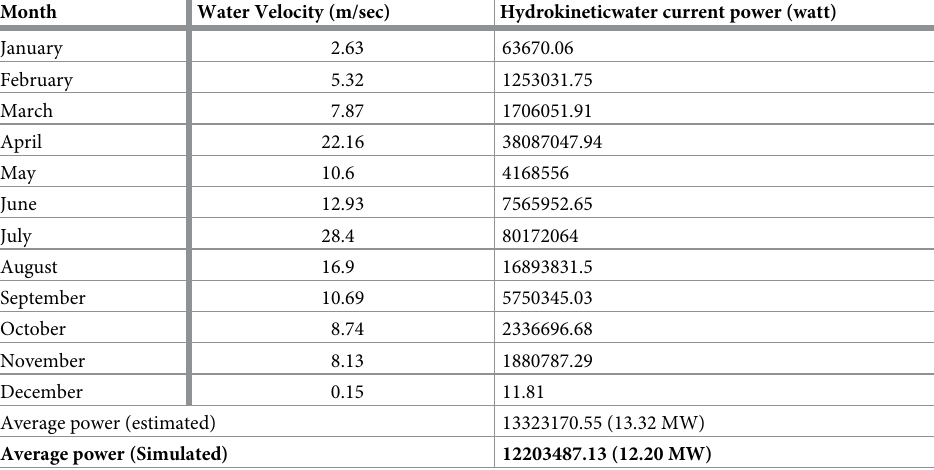
Table 3. Estimation of output power using historical data of water